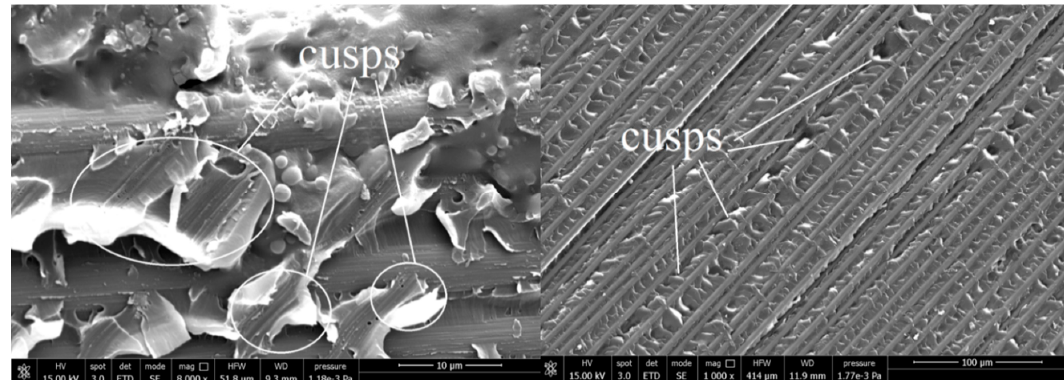
Figure 9. Delamination surfaces after the SEM investigations of the bending-extension specimen.